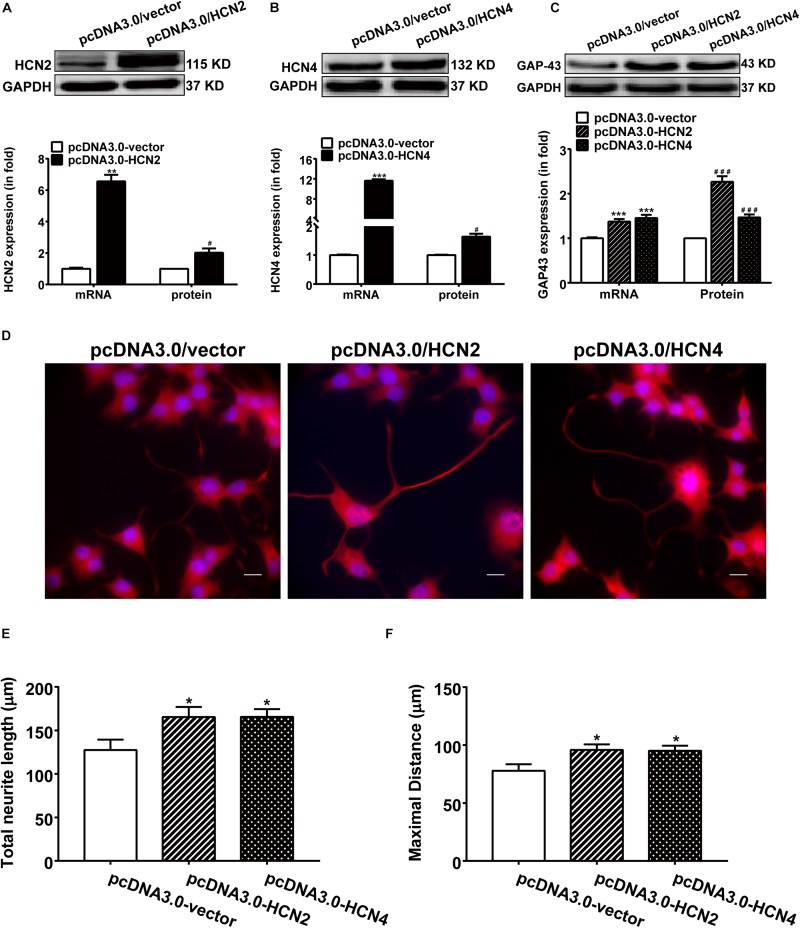
Overexpression of HCN2 and HCN4 enhanced GAP-43 expression and neurite outgrowth in PC12 cells. Results were obtained 48 h after cell transfection with either empty plasmid pcDNA3.0/vector or pcDNA3.0/HCN2 or pcDNA3.0/HCN4. (A,B) Representative western blots (upper) and semiquantitative values (lower) of the mRNA and protein levels of HCN2 and HCN4 isoforms. ∗∗p < 0.01, ∗∗∗p < 0.001 vs. control (pcDNA3.0/vector) in the mRNA level. #p < 0.05 vs. control (pcDNA3.0/vector) in the protein level, n = 4−6 independent experiments. (C) qPCR and western blotting results showing the effects of HCN2 or HCN4 overexpression on the mRNA and protein expressions of GAP-43. ∗∗∗p < 0.001 vs. empty plasmid in the mRNA level. ###p < 0.001 vs. empty plasmid in the protein level, n = 4−6 independent experiments. (D) Immunofluorescent stains of GAP-43 (red) of PC12 cells transiently transfected respectively with pcDNA3.0/vector, pcDNA3.0/HCN2 or pcDNA3.0/HCN4 plasmids. Scale bar, 10 μm. (E,F) Quantification of neurite morphological parameters including total neurite outgrowth and longest process per cell. Results are calculated from three independent experiments and presented as mean ± SEM, 50 < n < 90, ∗p < 0.05 vs. empty vector.